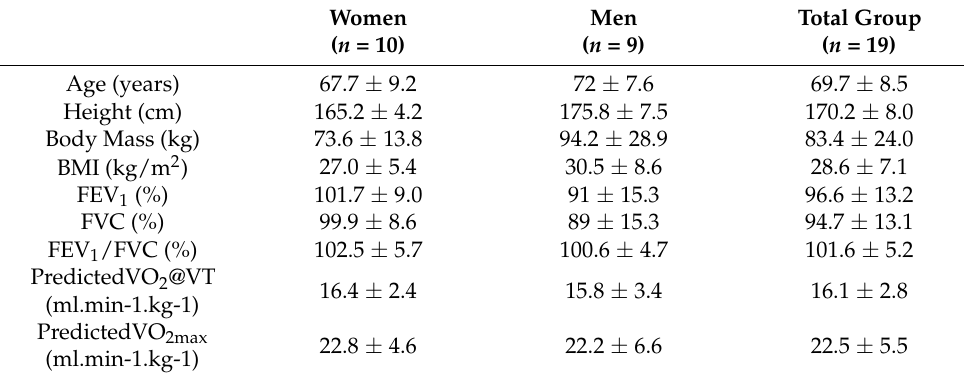
Table 1. Descriptive